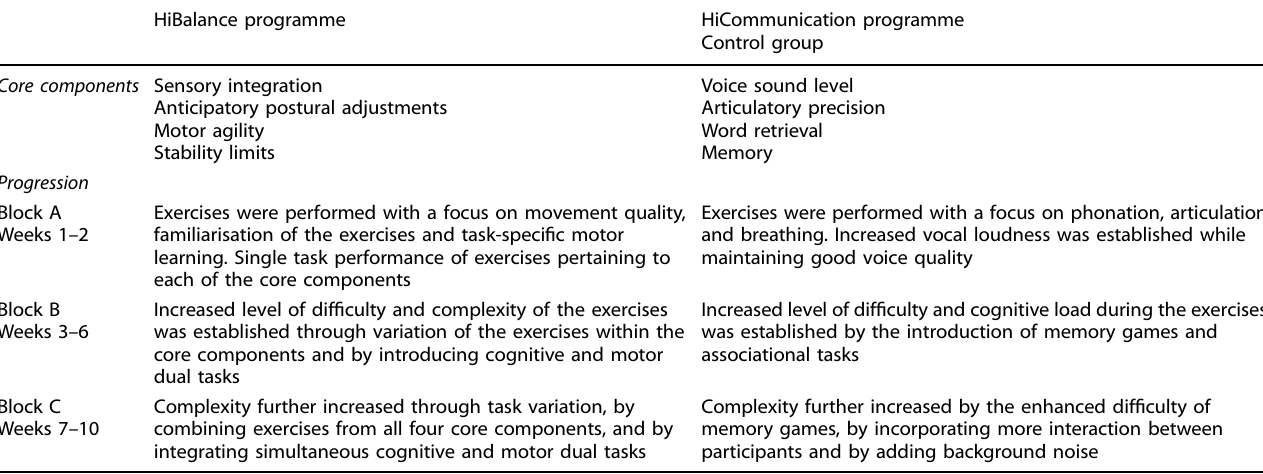
Table 3. Description of the core components and the progression of the HiBalance programme and the active control group